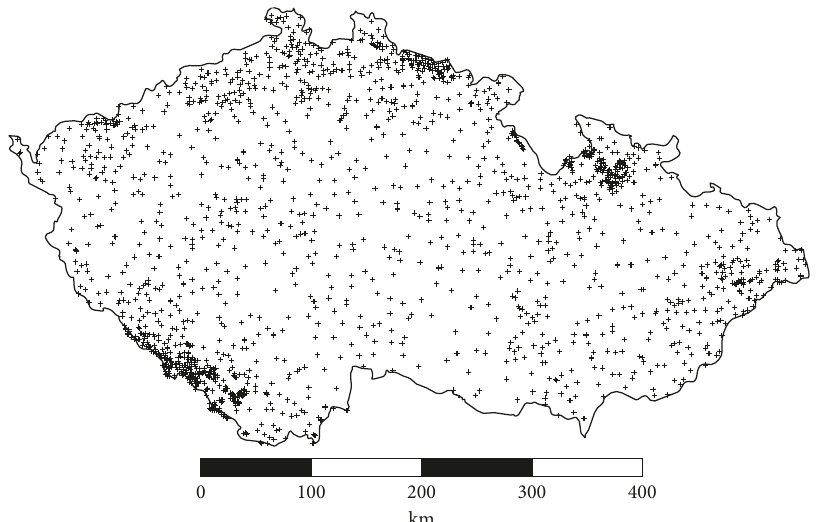
Figure 4: Publicly available control points.